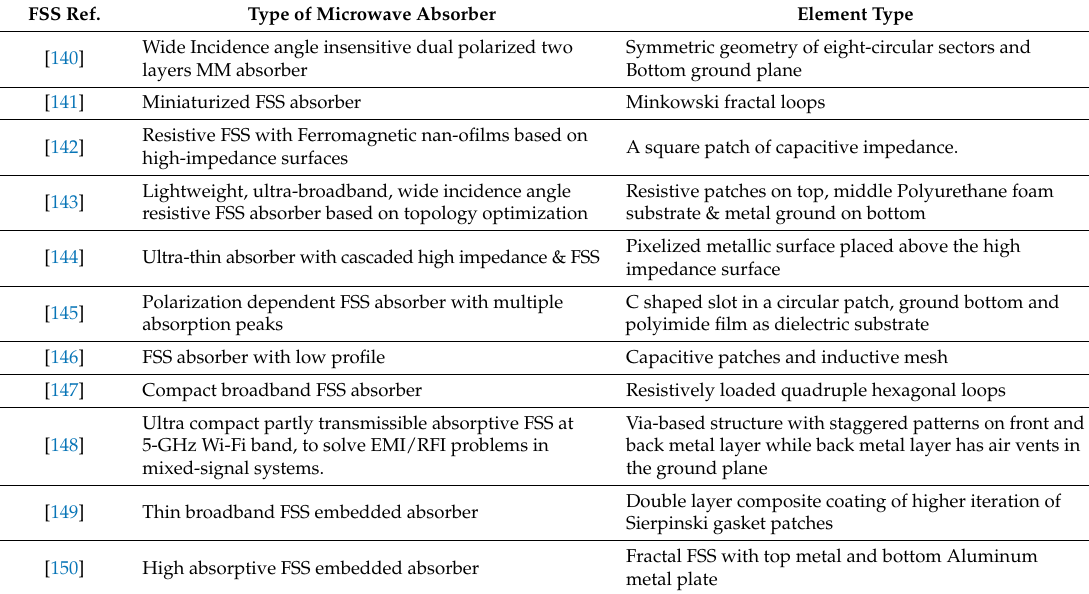
Figure 16. ( a ) Trend graph showing effect of altering the bias voltage on resonance frequency. ( b ) Unit cell geometry ( c ) The topology of tunable FSS absorber. Table 7. An overview of microwave FSS